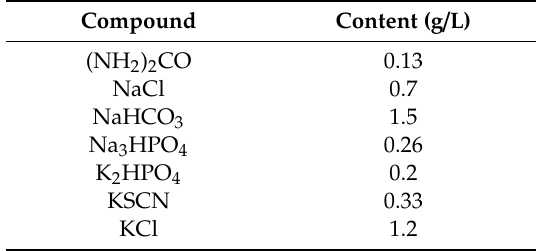
Table 1. Hydrochloric acid (4M) (HCl) was used to prepare solutions of the appropriate pH values of 3, 5, and 7. The Elmetron CPI-505 pH meter was used to measure the pH values. Table 1. Chemical composition of the artificial